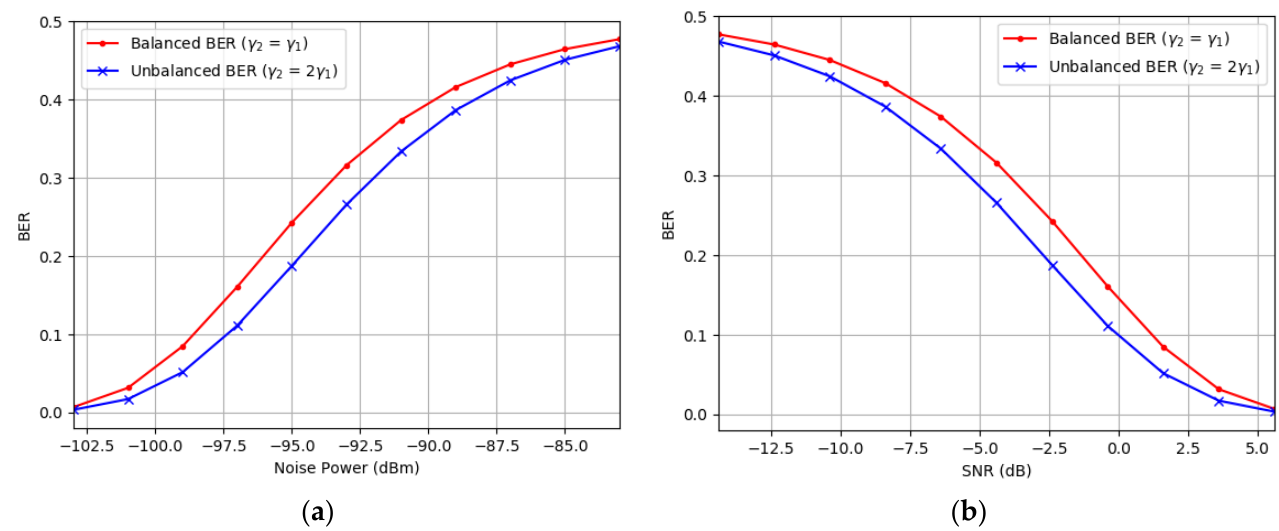
Figure 8. Variation in the BER for balanced ( 𝛾 2 = 𝛾 1 ) and unbalanced ( 𝛾 2 = 2𝛾 1 ) dual-hop scenarios: plots of ( a ) BER vs. Noise Power ( 𝑃 𝑛 (𝑑𝐵𝑚) ) and ( b ) BER vs. SNR.